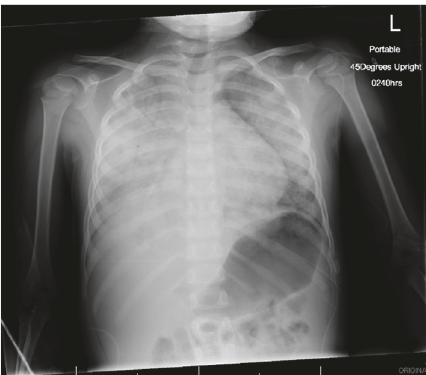
Figure 1: Radiograph on day of admission. Radiograph showing dense consolidation of the right lung obscuring the cardiothymic silhouette and tracheal deviation towards the right. Bilateral consol- idation with associated air